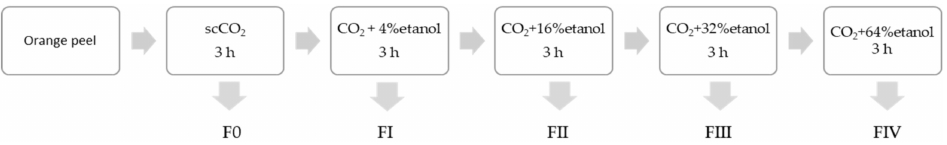
Figure 2. Extraction conditions for sequential